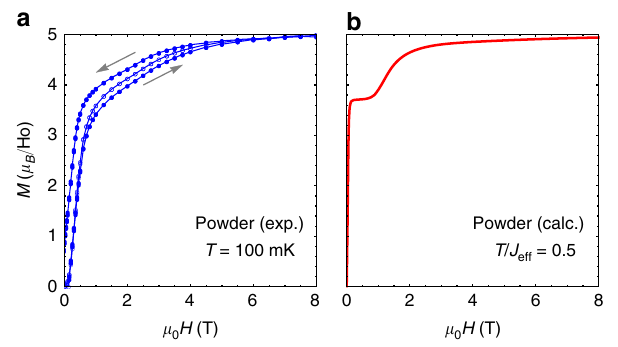
Fig. 4 Magnetization, measurements and calculations. a M vs H measured at 110 mK. The empty symbols show the fi rst magnetization curve and the fi lled symbols the magnetization curves obtained afterwards by ramping the fi eld up and down. The small hysteresis opening is due to the existence of slow dynamics at low temperature. b Calculated M vs H for h loc / J eff = 4.5 and T / J eff = 0.5, performing a powder averaging. The anomalies, mimicking the experimental curve, feature the existence of an exotic fi eld- induced behavior exhibiting